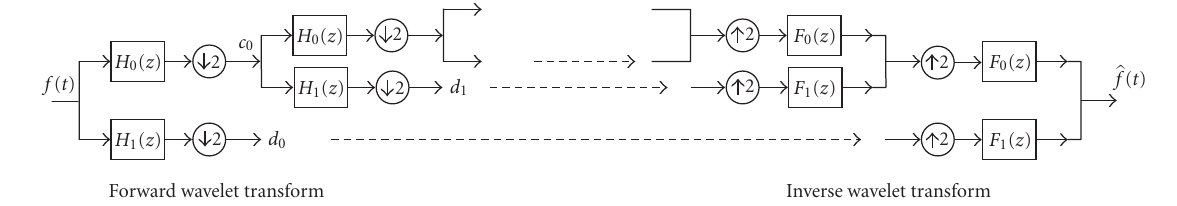
Figure 1: Filter bank representation of wavelet